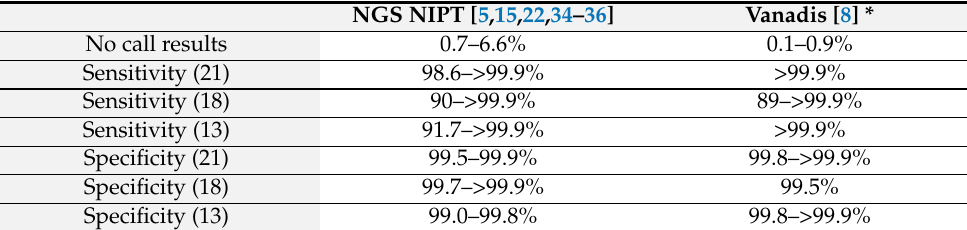
Table 4. Comparison of next-generation sequencing NIPT vs. Vanadis ®